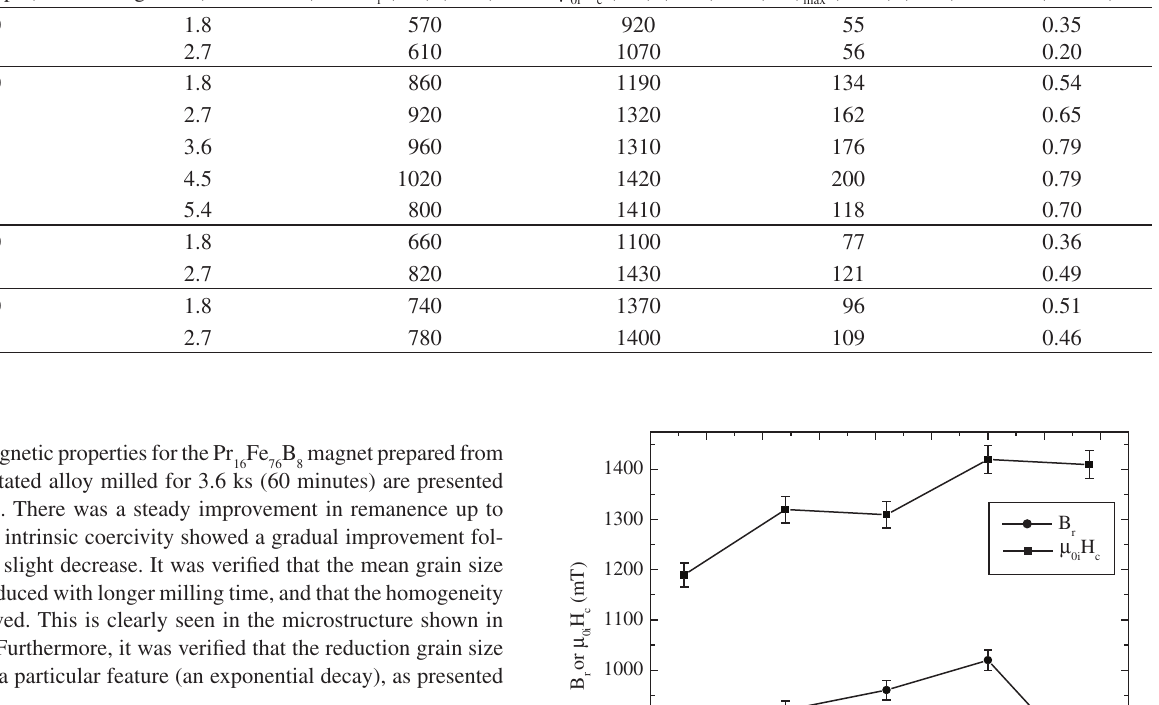
Table 2. Remanence, coercive field, maximum energy product and squareness factor of the Pr Speed (rpm)